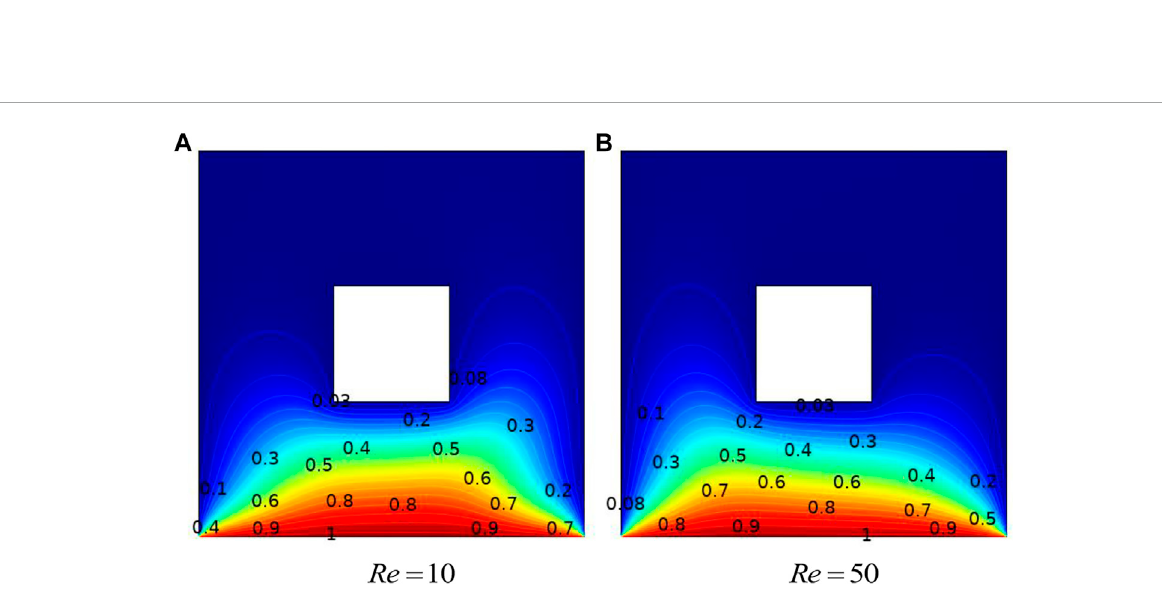
FIGURE 6 In fl uence of Re on isotherms with a uniformly heated bottom wall: cold cylinder case, Ha (cid:2) 20 and Gr (cid:2) 10 4